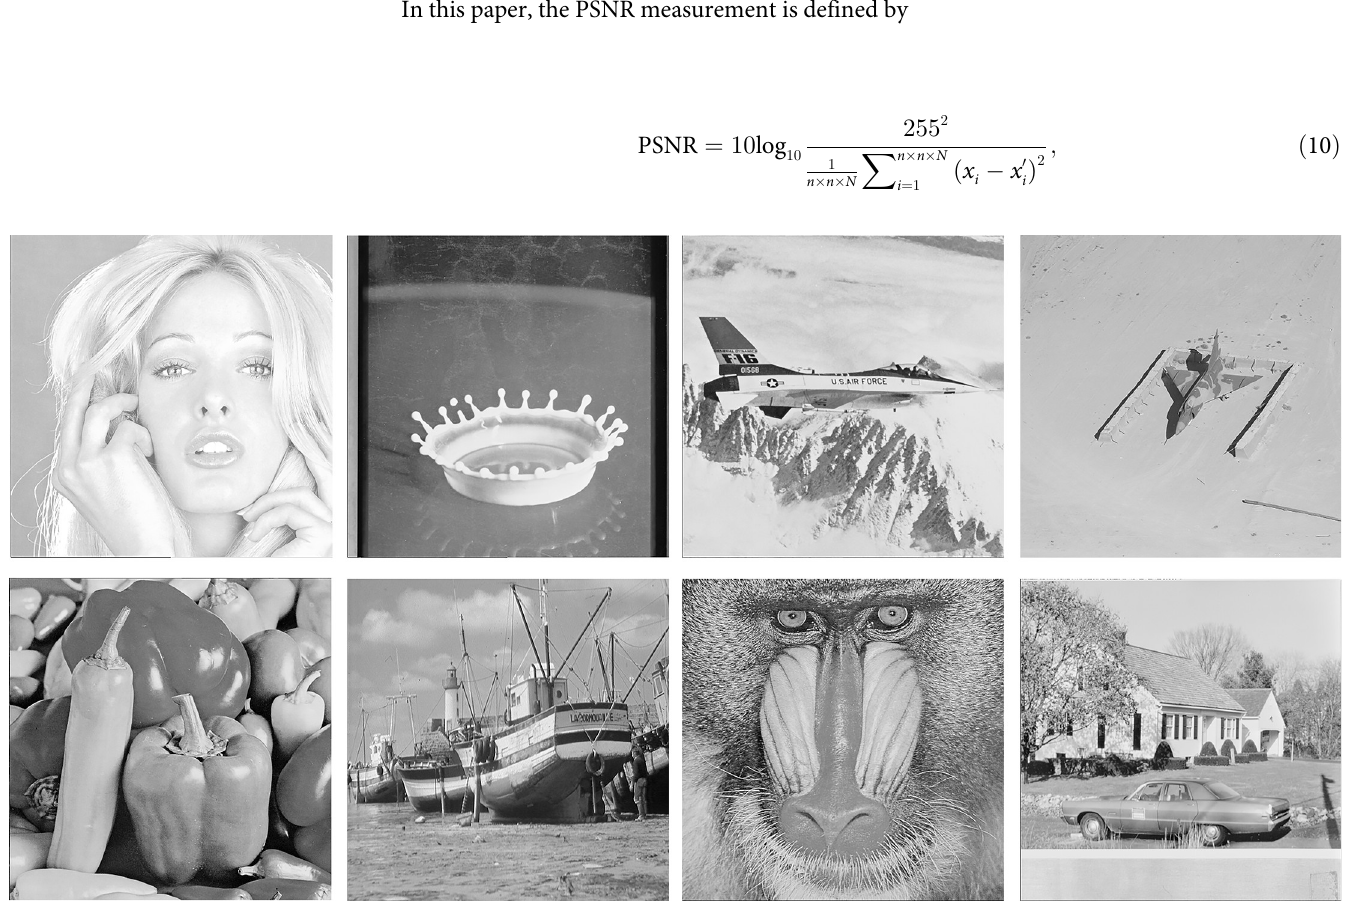
Fig 6. Eight test images of size 512 × 512. (a) Tiffany. (b) Splash. (c) Jet. (d) Airplane. (e) Peppers. (f) Boat. (g) Baboon. (h)